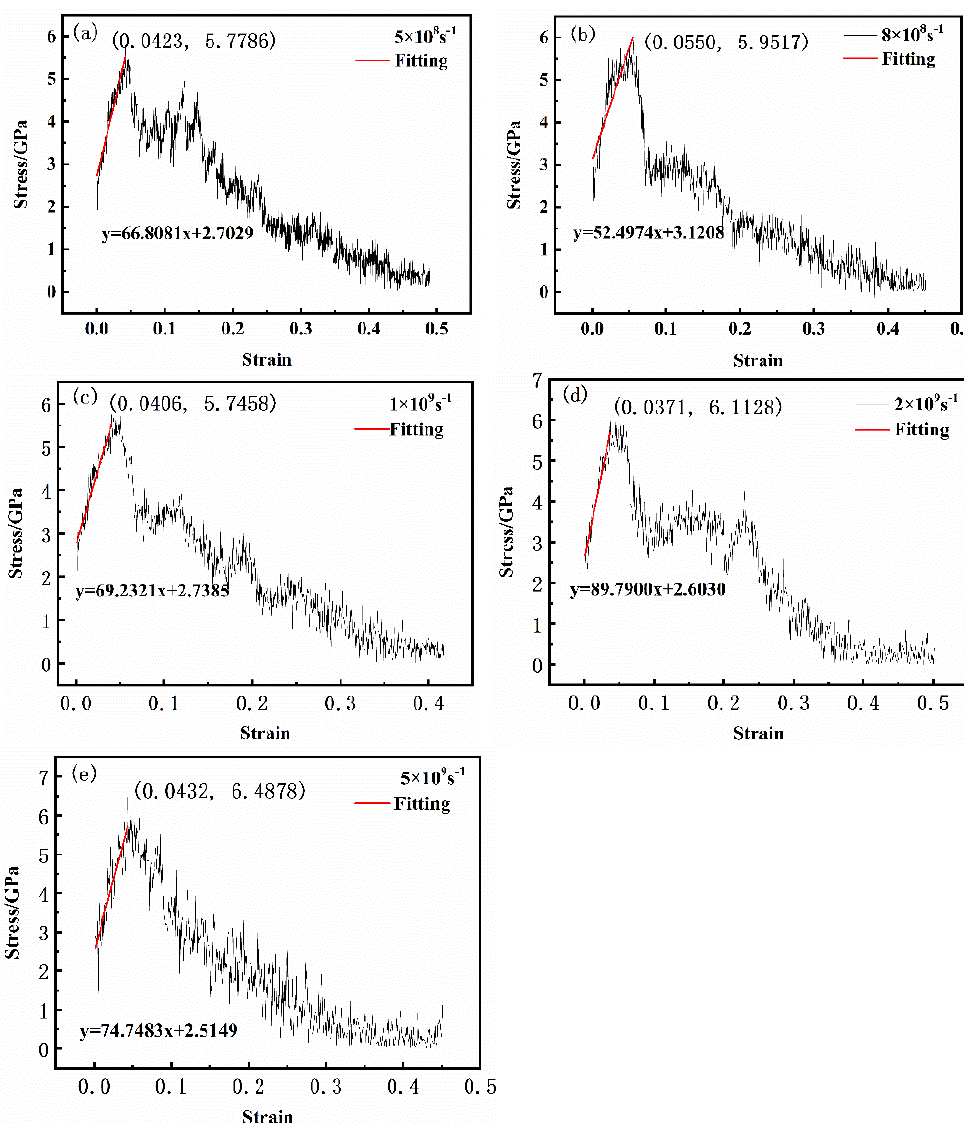
Figure 3. Stress–strain curves of SC-HEA at different strain rates at 300 K: ( a ) 5 × 10 8 s − Figure 3. Stress – strain curves of SC-HEA at different strain rates at 300 K: ( a ) 5 × 10 8 s −1 ( b ) 8 × 10 8 s −1